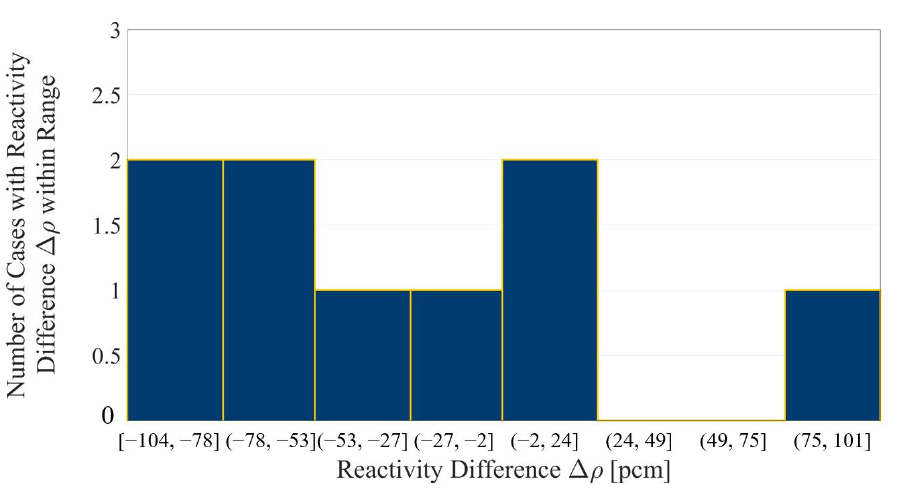
Figure 10. Histogram of reactivity differences for 3.64 wt.% UO 2 “fine” single fuel pin cases.